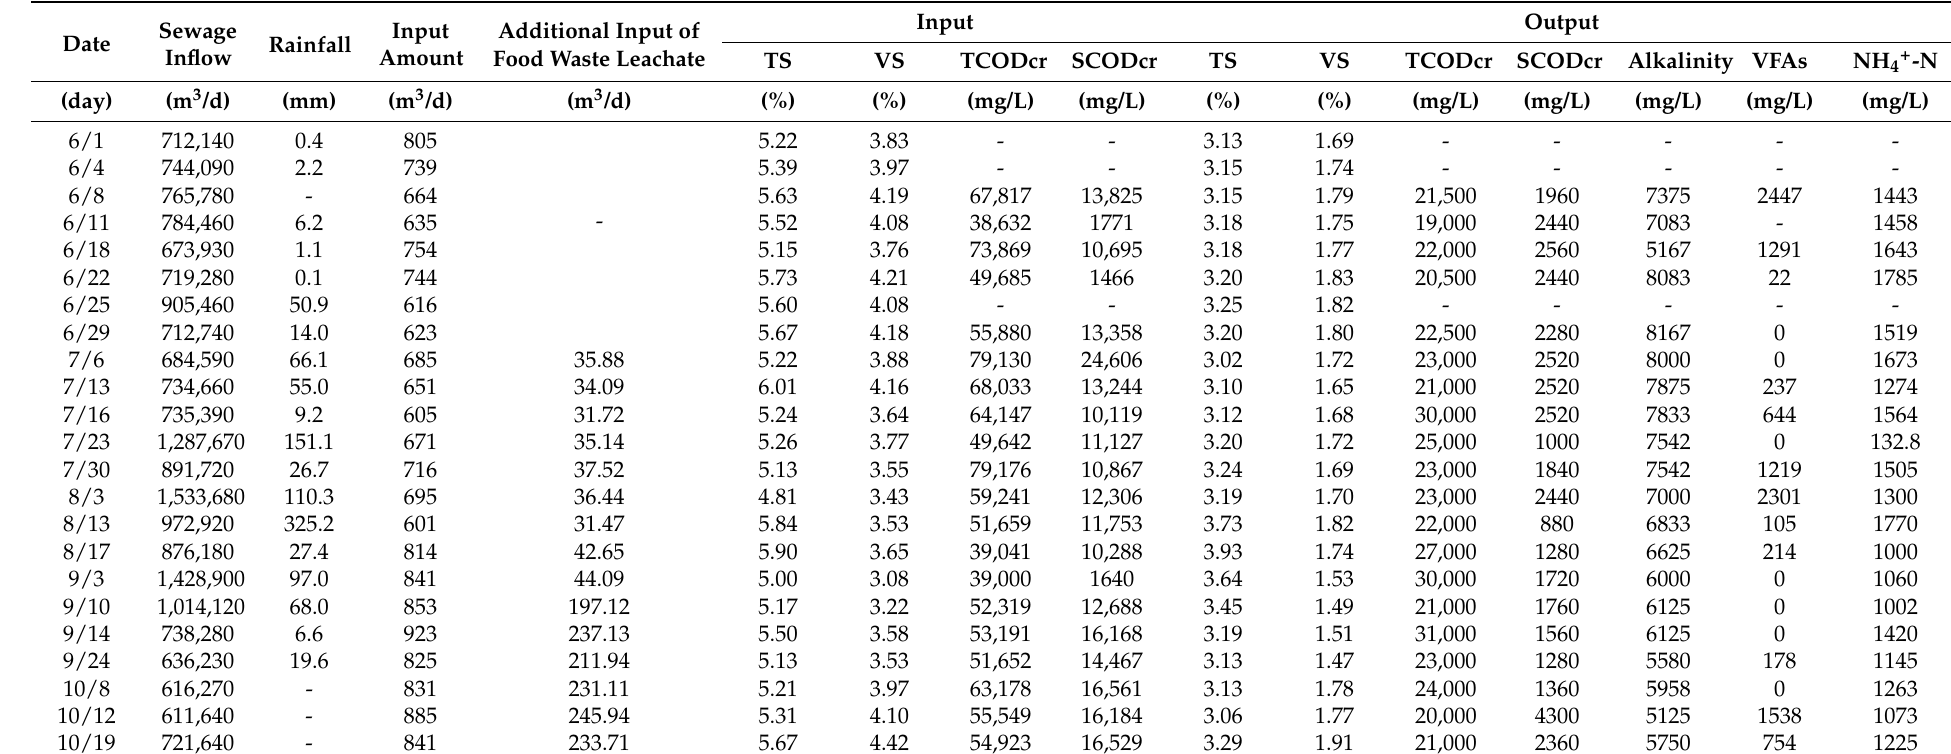
Table 5. Parameter values for the input and output